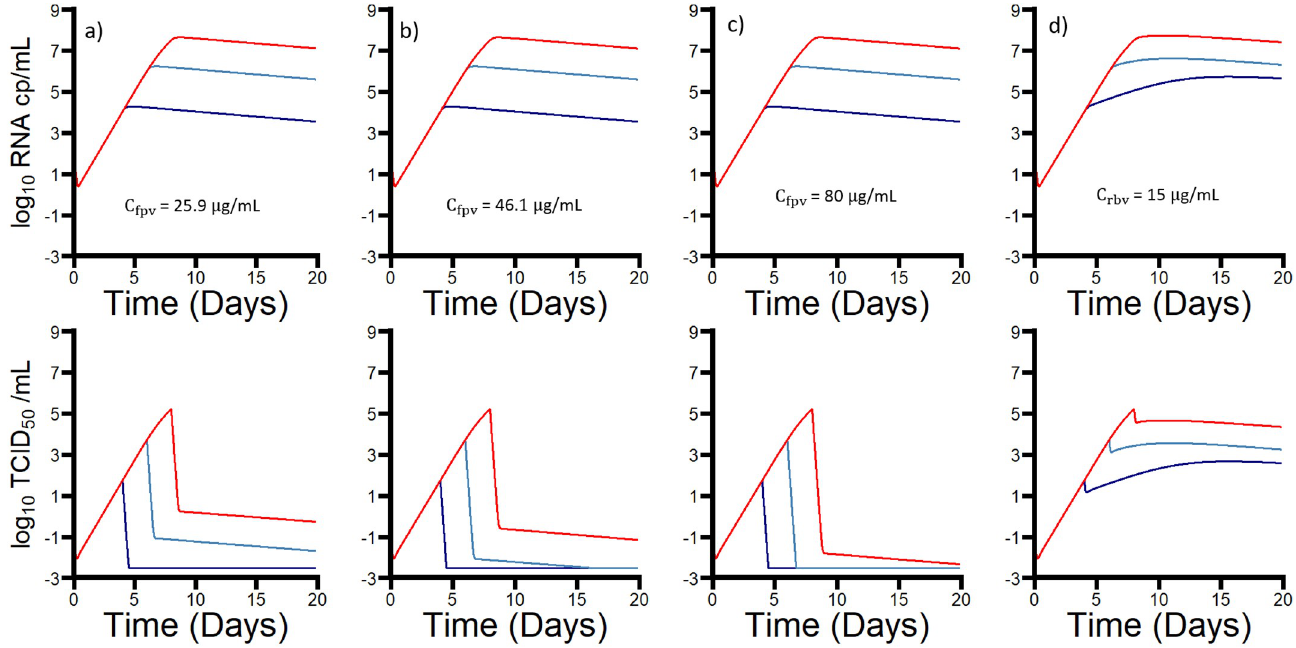
Fig 4. Mutagenesis model simulations. Constant favipiravir plasmatic concentration (a-c) or constant ribavirin plasmatic concentration (d). Treatment started at D4 (navy blue), D6 (blue), or D8 (red).